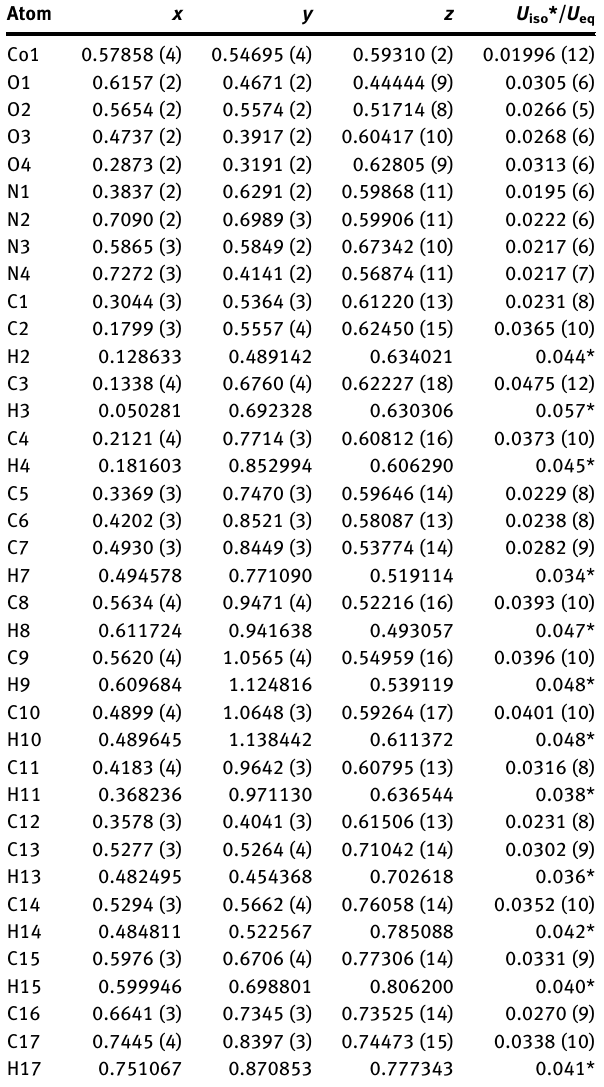
Table  : Fractional atomic coordinates and isotropic or equivalent isotropic displacement parameters (Å  ).